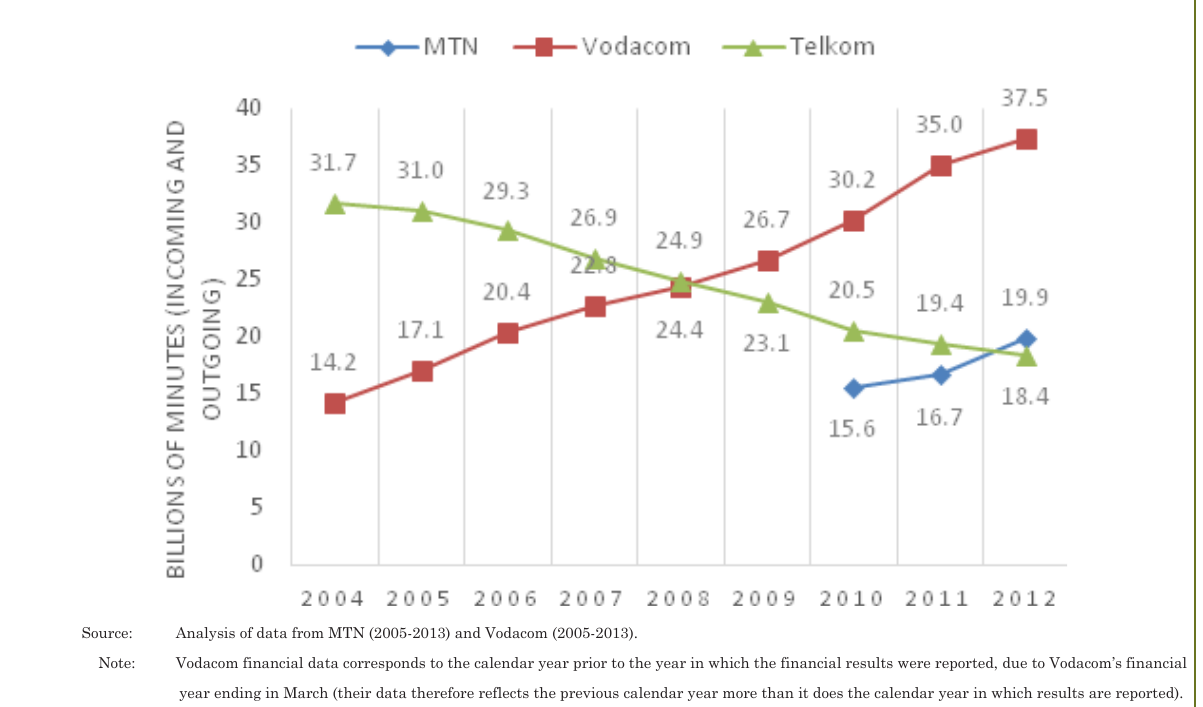
FIGURE 3:MTN, VODACOM AND TELKOM MINUTES OF USE (BILLIONS, 2004-2012)